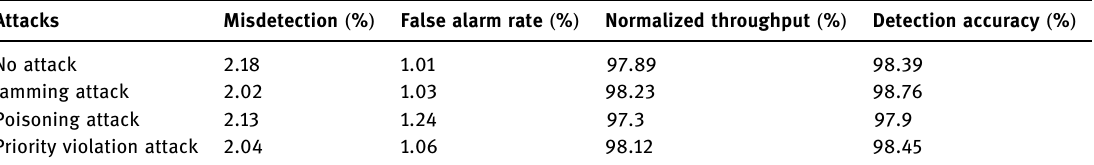
Table 2: Overall e ffi ciency